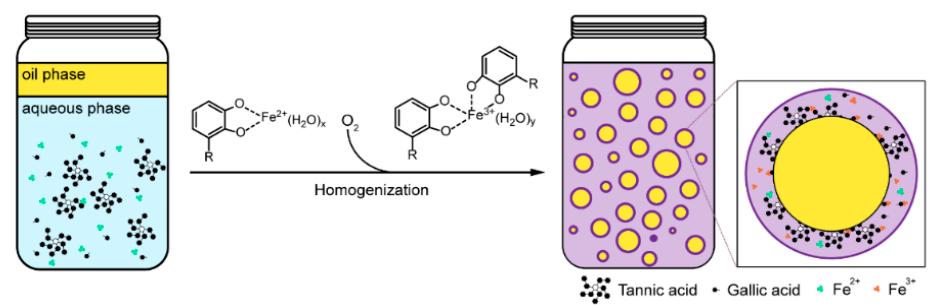
Figure 1. Schematic of the surfactant ‐ free emulsion formation, inspired by the iron gall ink (IGI).